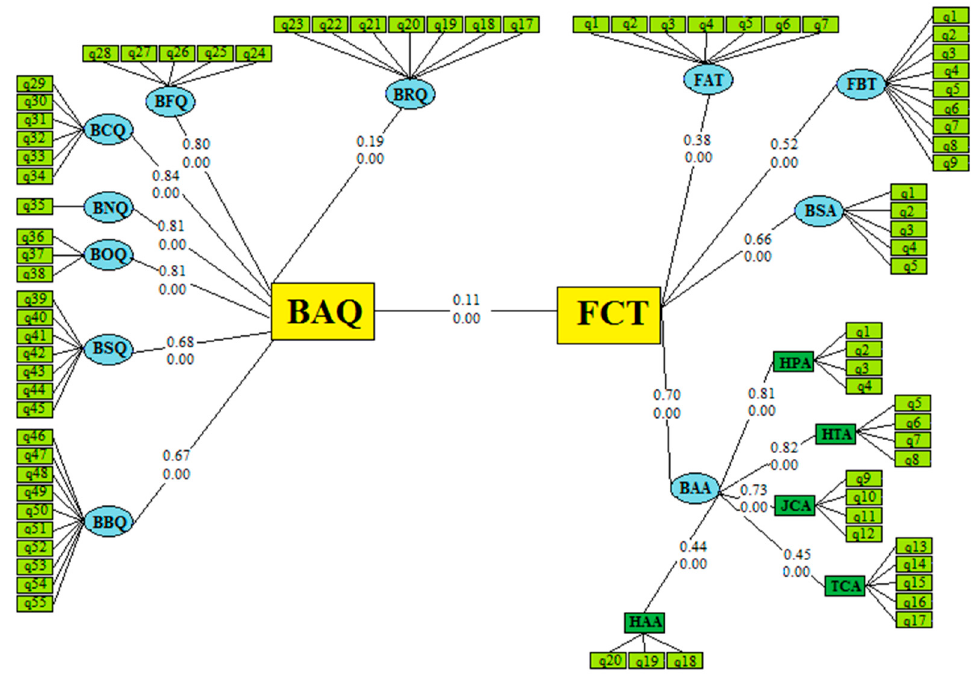
Figure 2. The effect of implicit and explicit variables on non-listed company data. Note: FCT is familiarity with blockchain technology (total questions); FAT is familiarity with blockchain technology, part 1; FBT is familiarity with blockchain technology, part 2; BAA is blockchain applications for accounting; HPA is hope (expectation of) to perform; HTA hopes to try; JCA is job communication; TCA is confidence; HAA is compatibility; BSA is blockchain applications for auditing; BAQ is quality of information (total questions); BRQ is relevance; BFQ is faithful representation; BCQ is comparability; BNQ is timeliness; BOQ is verifiability; BSQ is understandability; and BBQ is blockchain on the quality of information.